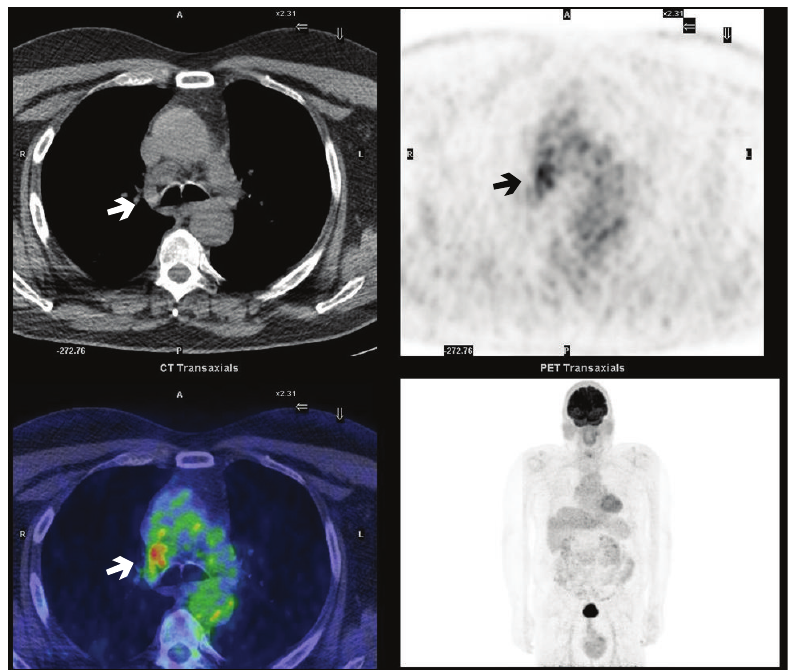
Figure 6: Right paratracheal suspicious lymphadenopathy at PET/CT scan—SUVmax 4.6